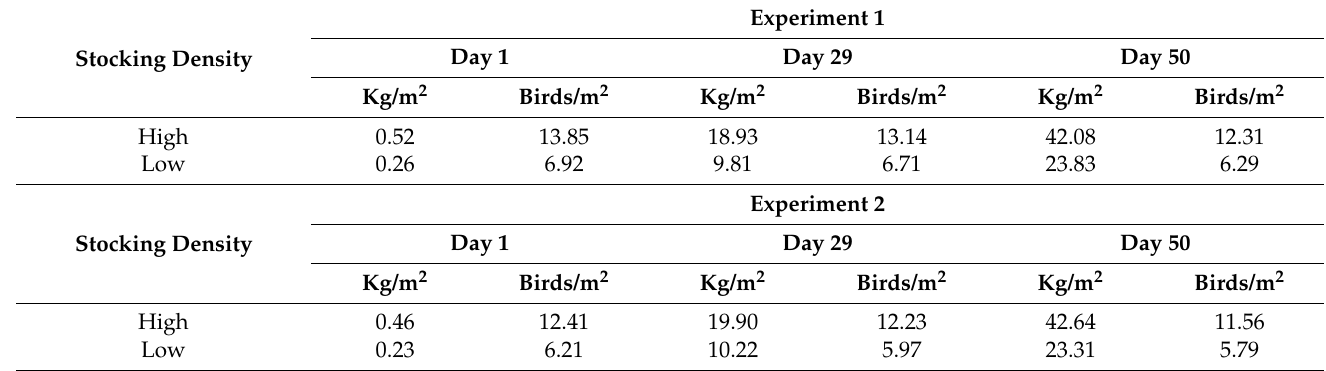
Table 2. Mean pen stocking density (kg/m 2 ), and birds/m 2 , at day 1, 29, and 50 in Experiments 1 and 2.